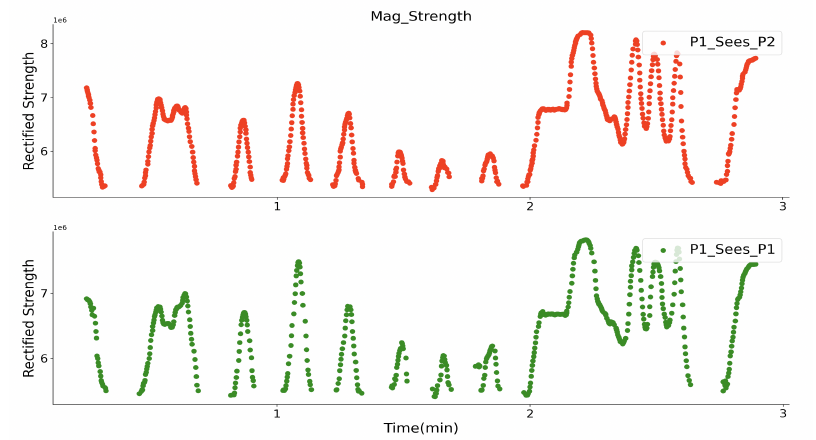
Figure 17. How each volunteer sees the walker-by in strength.